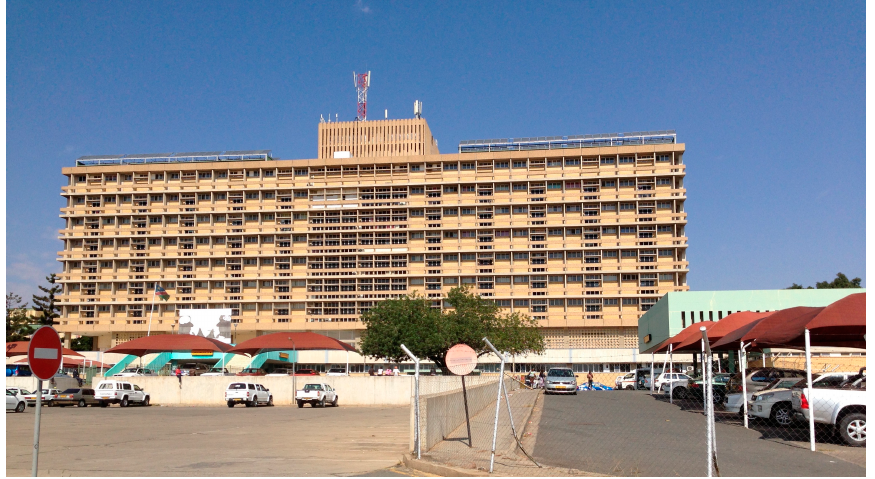
Figure 1. The Windhoek Central Hospital.